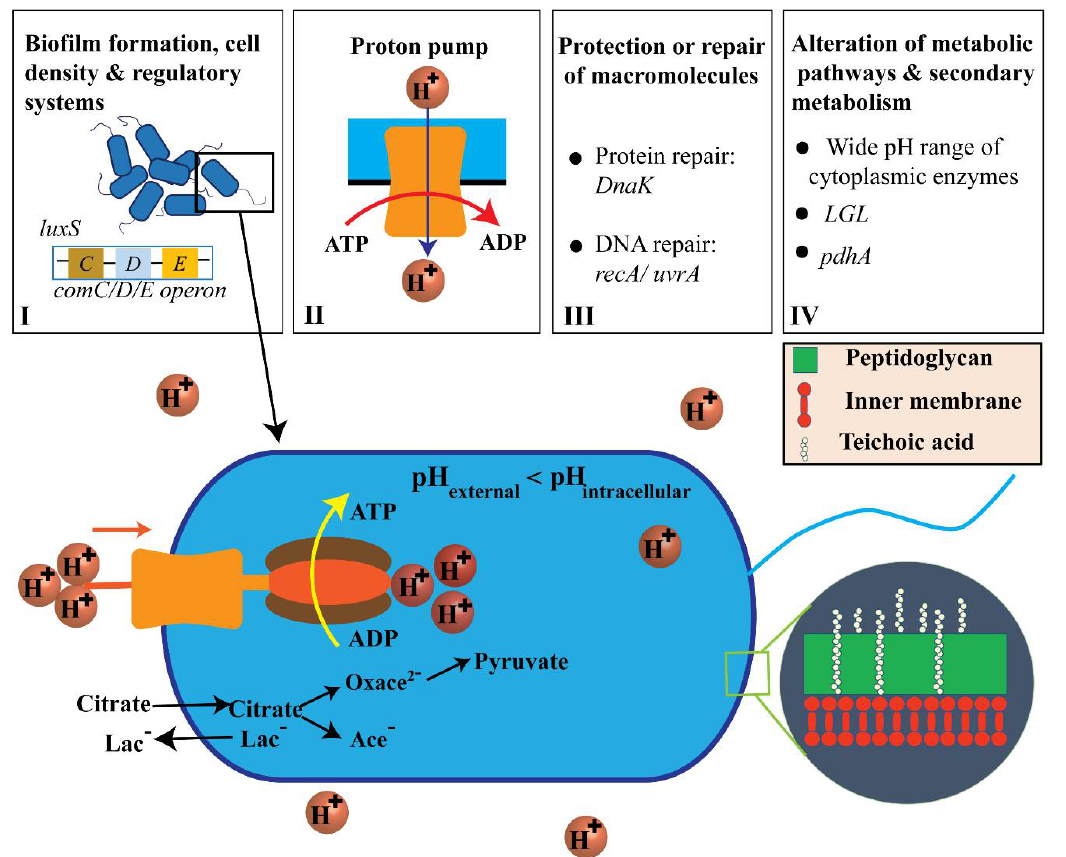
Figure 7. Adenosine triphosphate (ATP) generation by transport and proton-consuming decarboxylation from citric acid and the acid-resistance mechanisms (ARMs) used by S. mutans (not to scale).